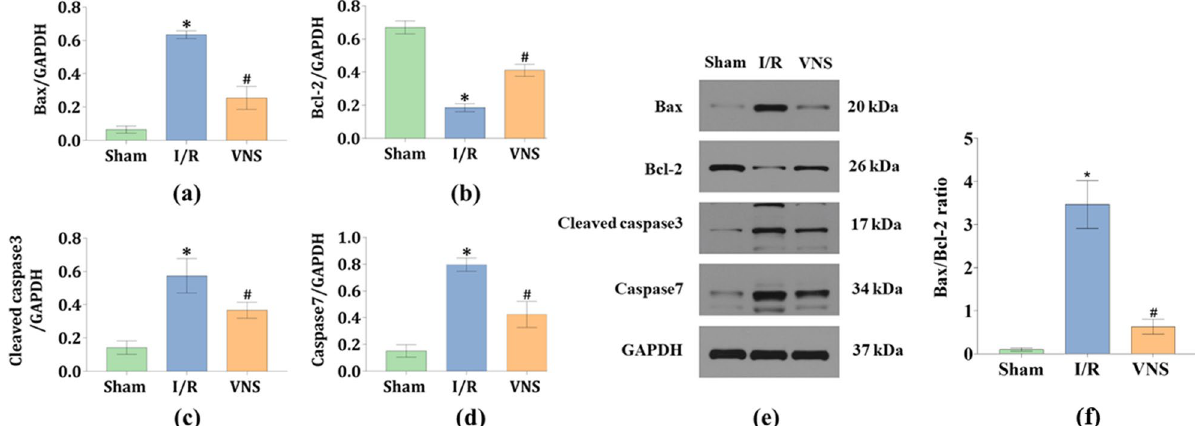
Figure 6. VNS reduces cell apoptosis by regulating Bax, Bcl-2, Cleaved caspase3, caspase7, and Bax/Bcl-2 ratio. ( e ) Representative blots and relative protein levels of ( a ) Bax, ( b ) Bcl-2, ( c ) Cleaved caspase3, and ( d ) caspase7 in kidney tissues from the three groups are shown. ( f ) Bax/Bcl-2 ratio is shown. *p < 0.05 vs. the Sham group; # p < 0.05 vs. the I/R group. Some blots were cut before hybridization with antibodies to optimize the use of the